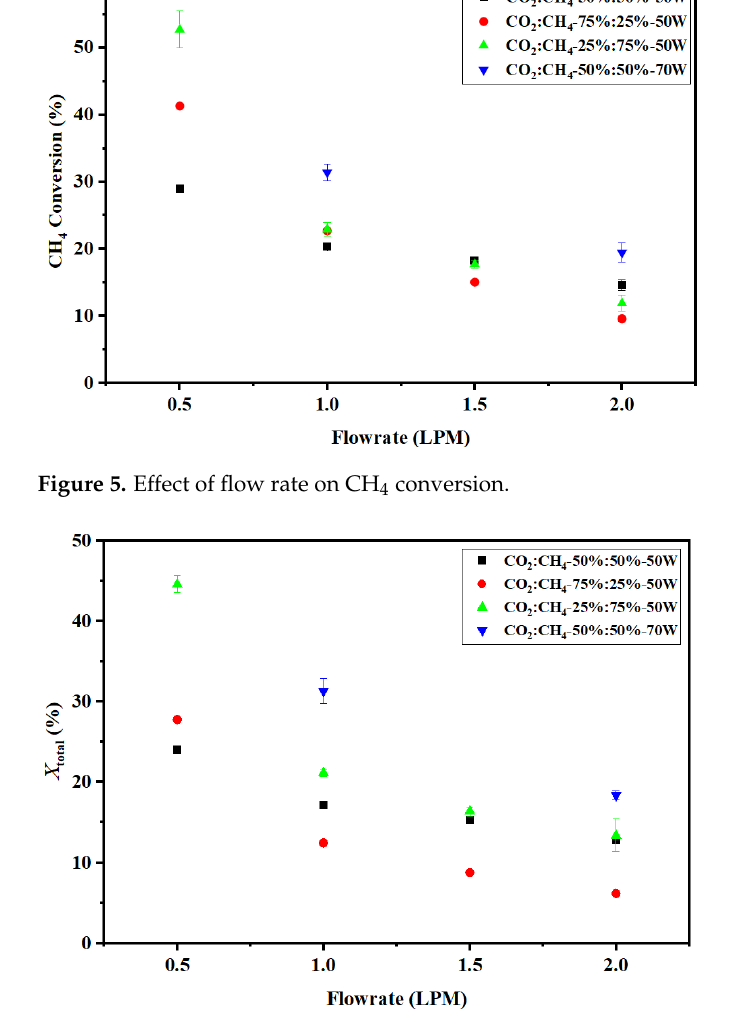
Figure 6. Effect of flow rate on total conversion.